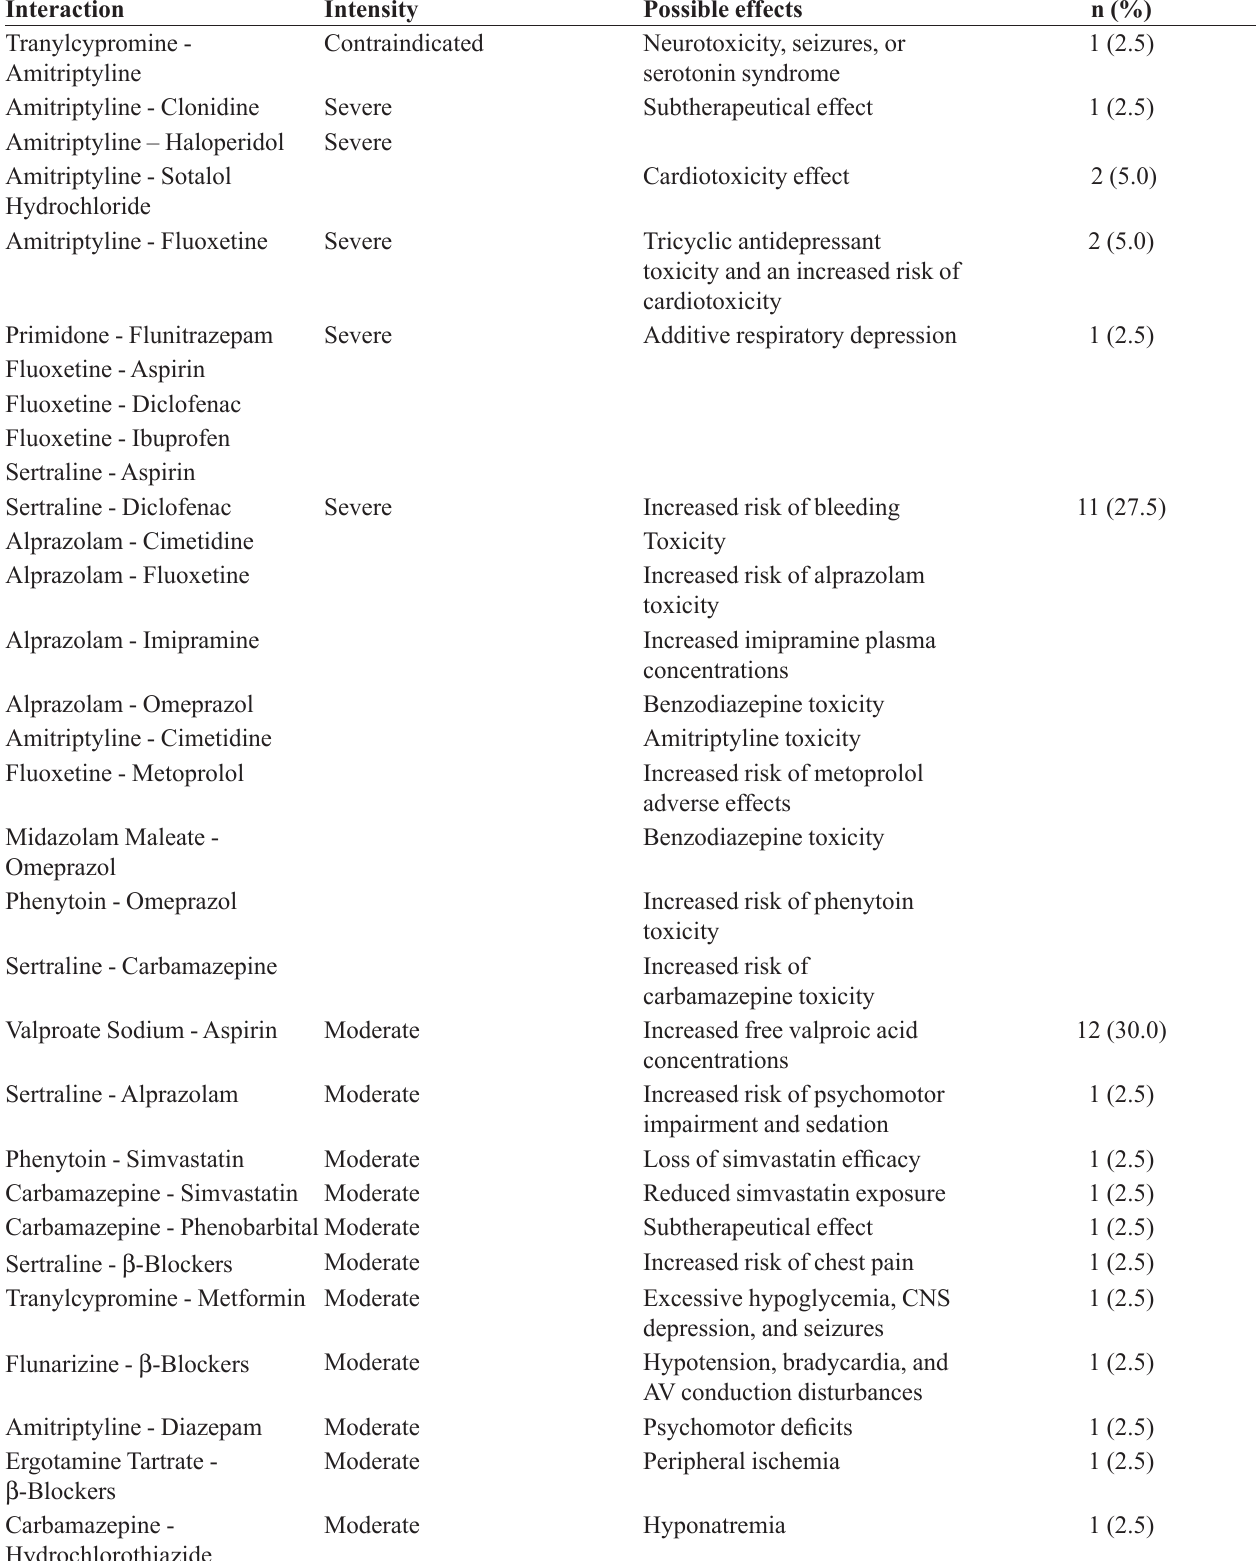
TABLE II - Potential drug-drug interactions, based on reported prescribed medications in the elderly sample population of (n=40)